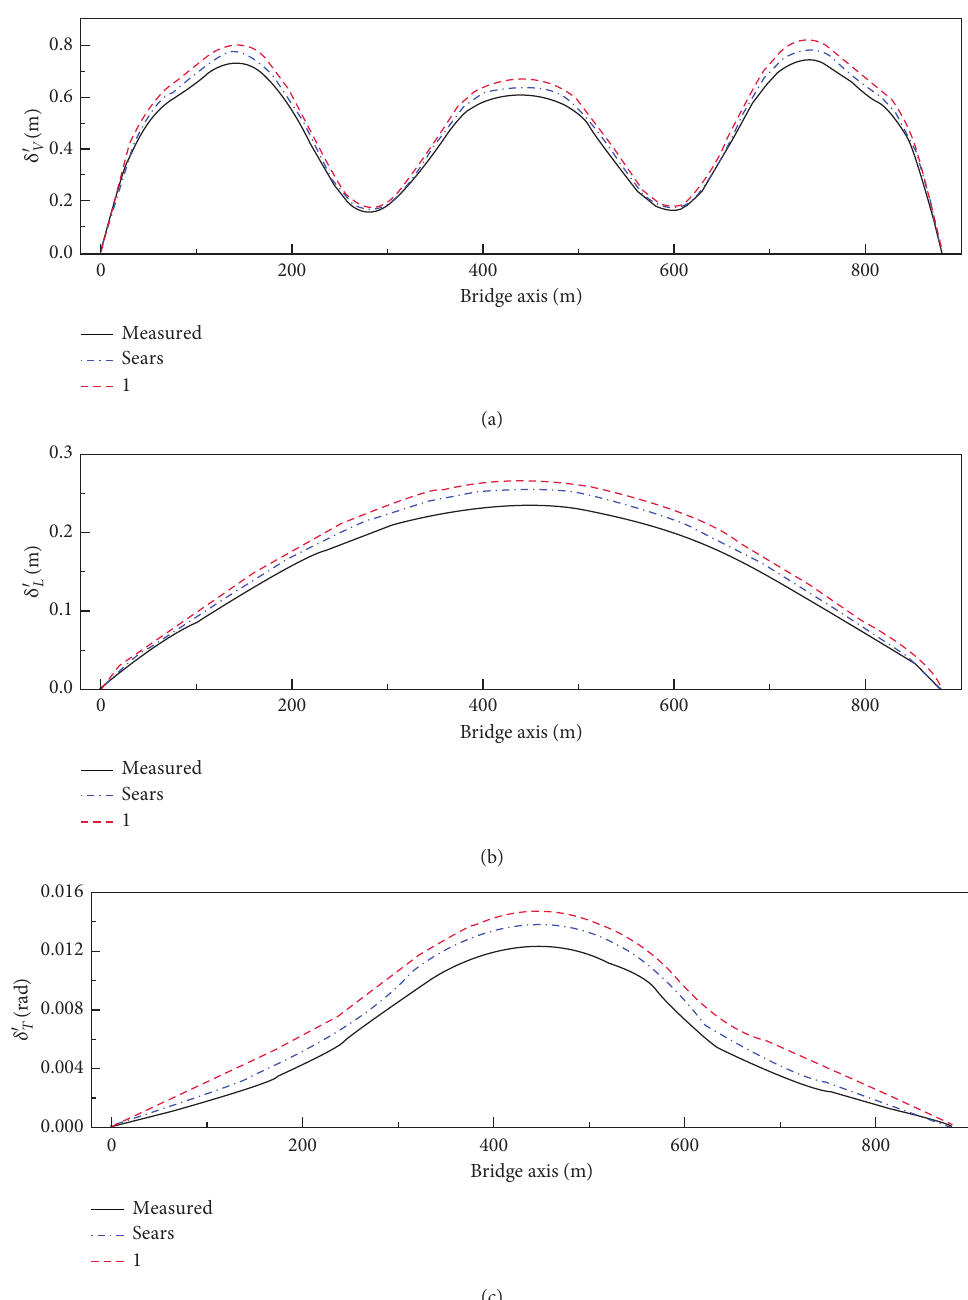
Figure 15: The influences of AAF on the buffeting responses at AoA of 0 ° (Case 1): (a) RMS vertical displacement δ displacement δ L ′ ; (c) RMS torsional displacement δ T ′